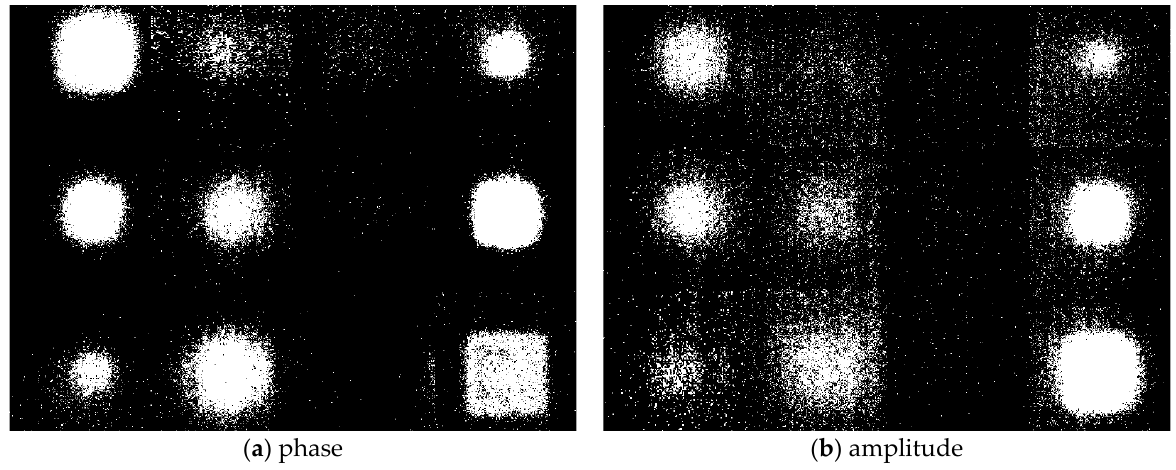
Figure 12. Binary images of phase and amplitude data using the Otsu algorithm.